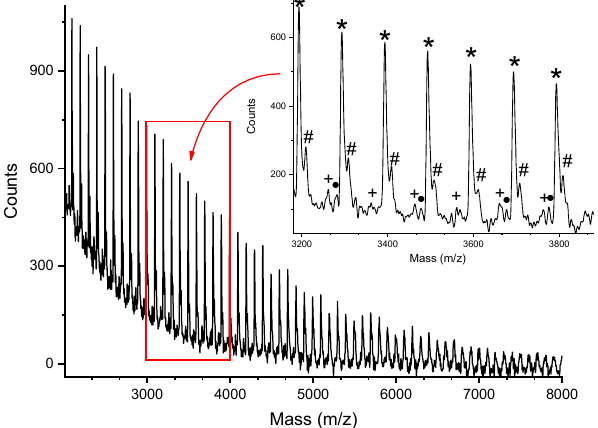
Figure 3. MALDI-TOF mass spectrum of pristine PMMA. The peaks are relative to chains terminated by disproportionation (“*”, MNa + ; “ # ”, MK + ) and by coupling mechanism ( “+”, MNa + ; “•”, MK + ).